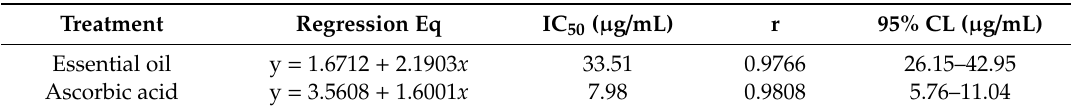
Table 5. IC 50 values of T . flousiana essential oil and ascorbic acid measured by 2,2-diphenyl-1-picrylhydrazyl